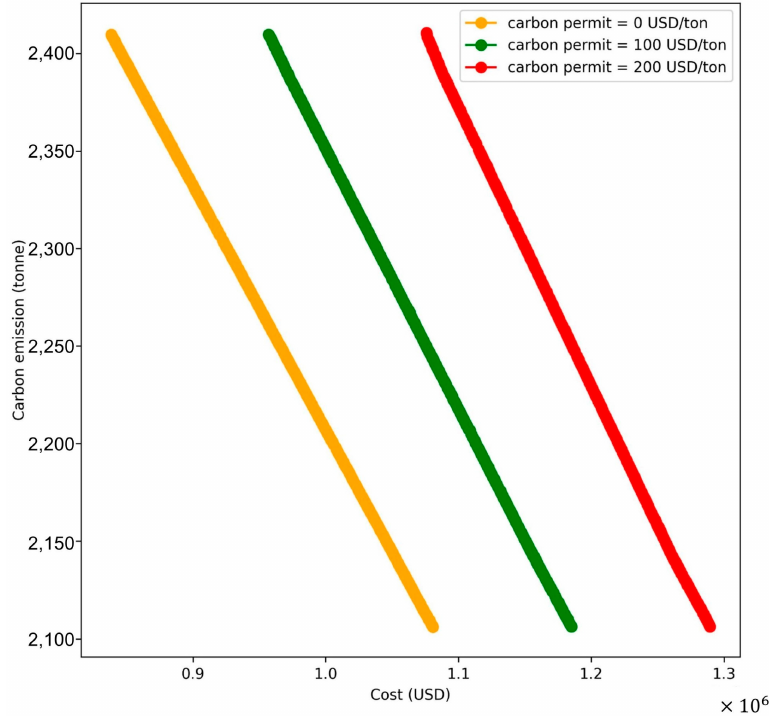
Figure 10. PFs (orange, green, red) represent scenario 2, scenario 4 with a 100 USD carbon permit, and scenario 4 with a 200 USD carbon permit,